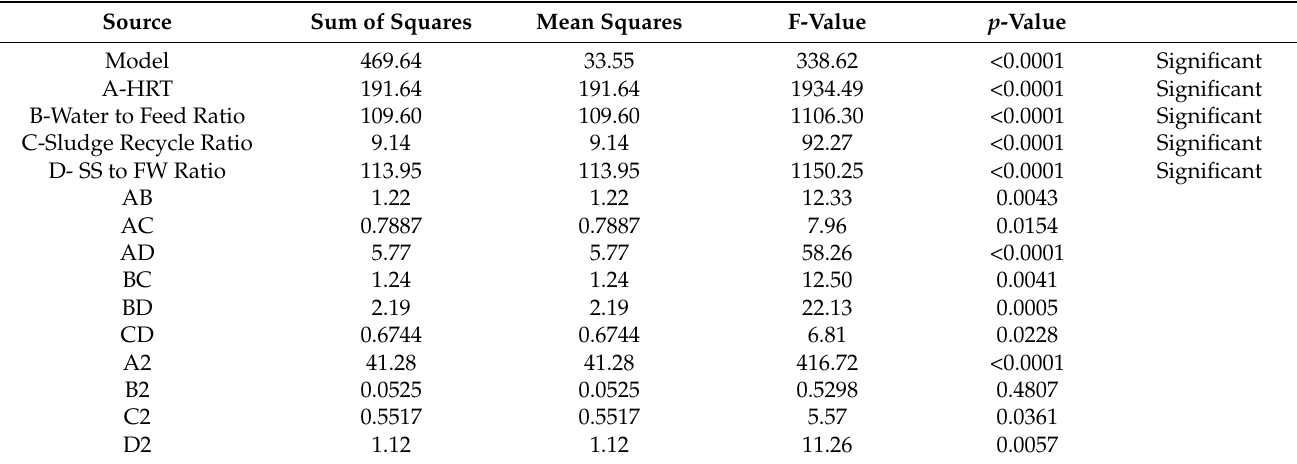
Table 6. ANOVA analysis for VS removal efficiency response.